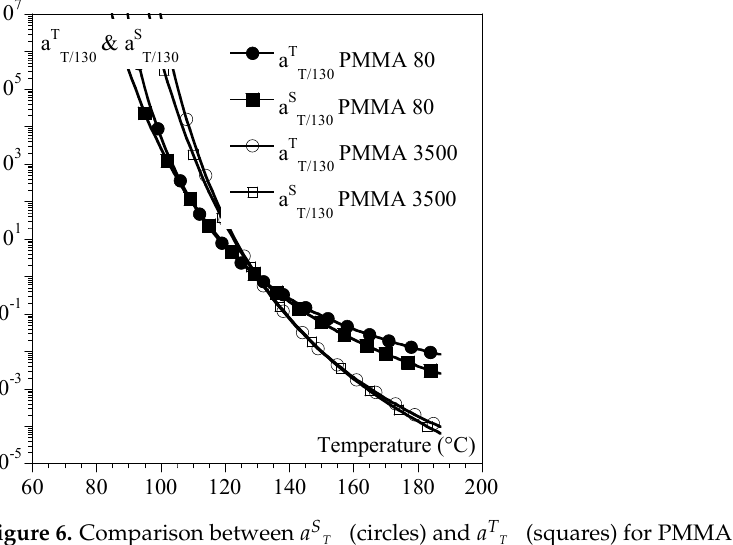
(circles) and a T (squares) for PMMA 80 (plain symbols) and (cid:3415)(cid:3020) (circles) and 𝑎 (cid:3415)(cid:3021) (squares) for PMMA 80 (plain symbols) T T (cid:3021) Tref Tref (cid:3021) (cid:3293)(cid:3280)(cid:3281) (cid:3021) (cid:3293)(cid:3280)(cid:3281)